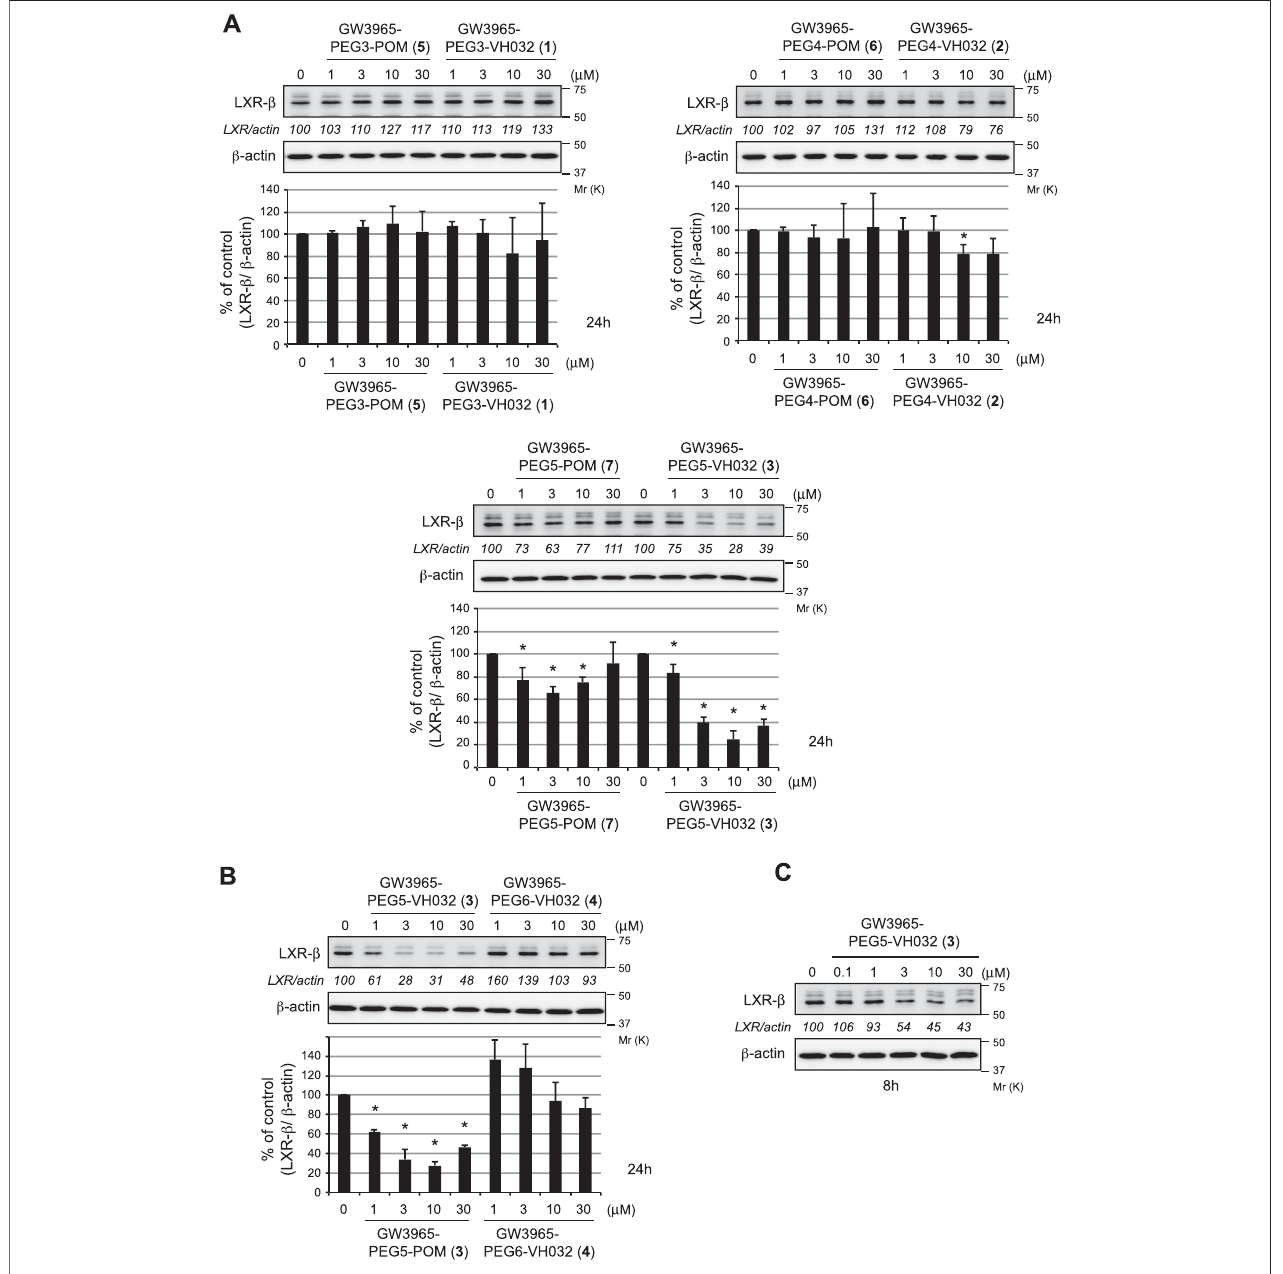
FIGURE 2 | Degradation of the LXR β protein by the synthesized compounds. HuH-7 cells that had been cultured in Dulbecco ’ s modi fi ed Eagle ’ s medium (DMEM) containing10%fetalbovineserum(FBS)weretreatedwiththeindicatedcompoundsfor24 h (A,B) or8 h (C) .Immunoblotsofthecelllysatesthathadbeenstainedwith theindicatedantibodiesareshown(representativedataareshown).ThenumbersbelowtheLXR β panelsrepresentLXR/actinnormalizedbydesignatingtheexpression from the vehicle control condition as 100%. Data in the bar graph are the mean ± S.D. (error bars) of three independent experiments. Asterisks indicate p < 0.05 compared with vehicle